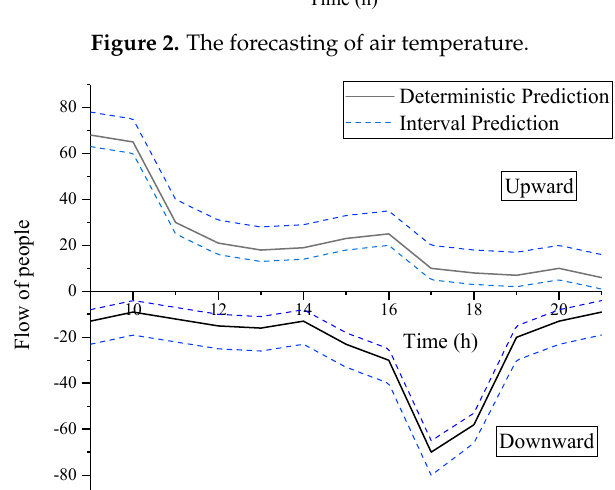
Figure 3. The forecasting of flow of people.